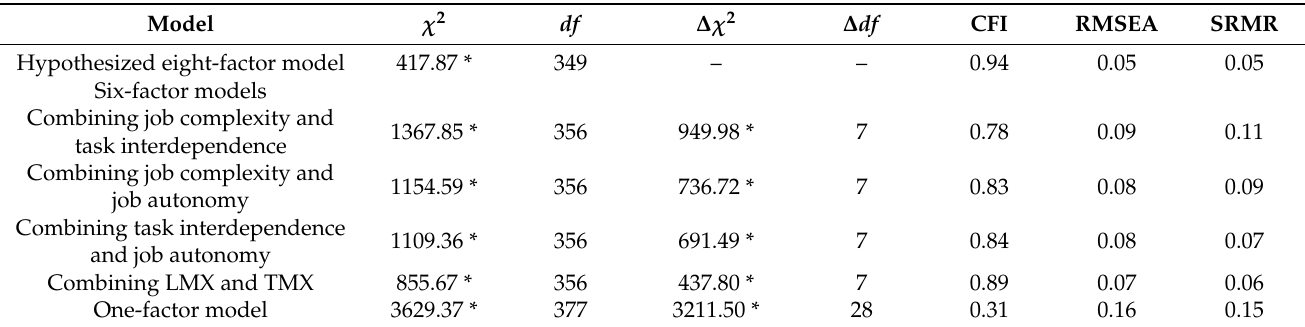
Table 1. Confirmatory Factor Analysis Results: Fit Indices.